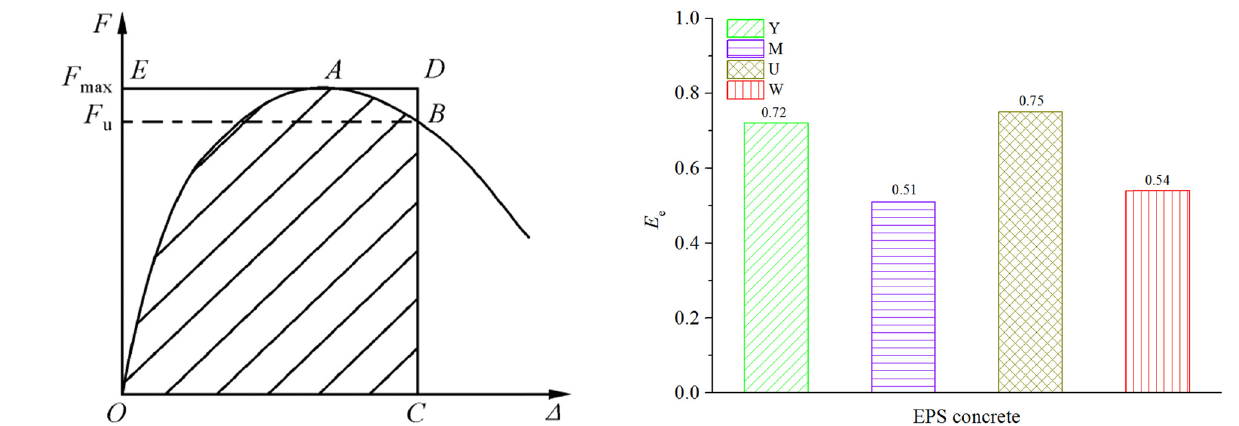
Figure 12: Schematic diagram of energy dissipation calculation [ 37 ] . Figure 13: Energy dissipation coe ffi